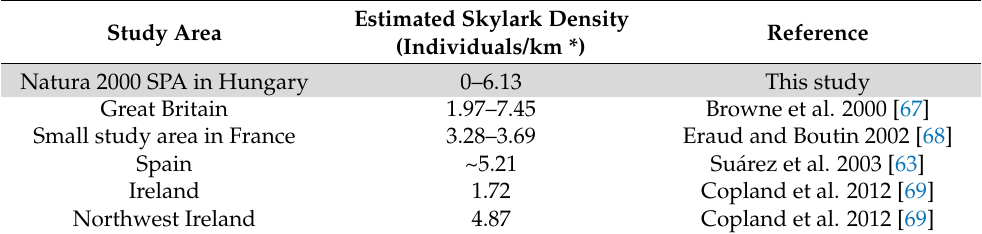
Table 5. Summary table of studies, which predicted the Eurasian skylark density inside European study